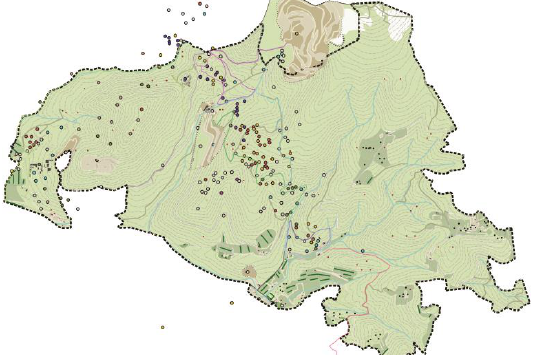
Figure 4. OpenLayer view of the published Web GIS